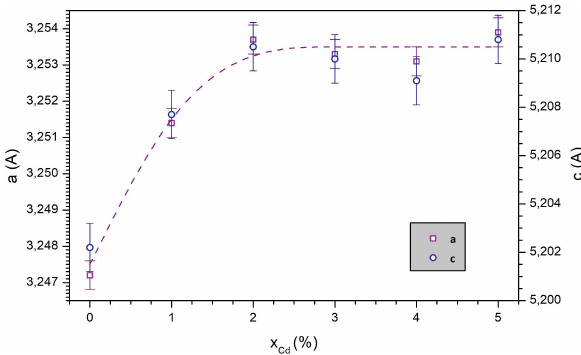
Figure 3: The dependence of zincite lattice parameters on cadmium share. The line has been introduced as a guideline for the eye.